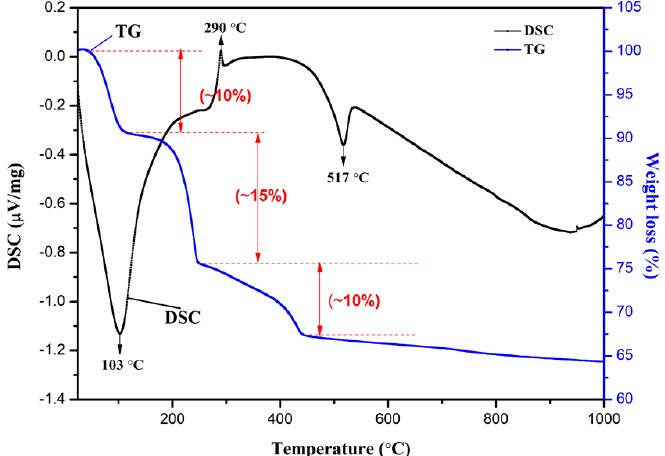
Figure 3. TG/DSC curve of the HAp-zirconia (HZ1) composite.